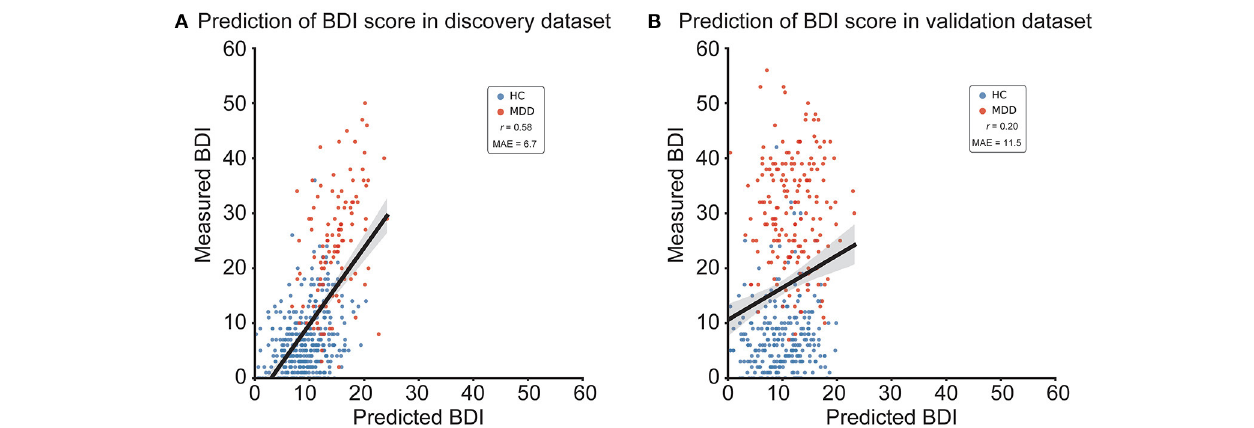
FIGURE 3 | BDI regression model performances in the discovery and validation datasets. (A) Scatter plots of measured and predicted BDI in the discovery dataset. (B) Scatter plots of measured and predicted BDI in the independent validation dataset. The solid line indicates the linear regression of the measured BDI from the predicted BDI. The correlation coefficient ( r ) and mean absolute error (MAE) are shown. Each data point represents one participant. BDI, Beck Depression Inventory-II; HC, healthy control; MDD, major depressive disorder.